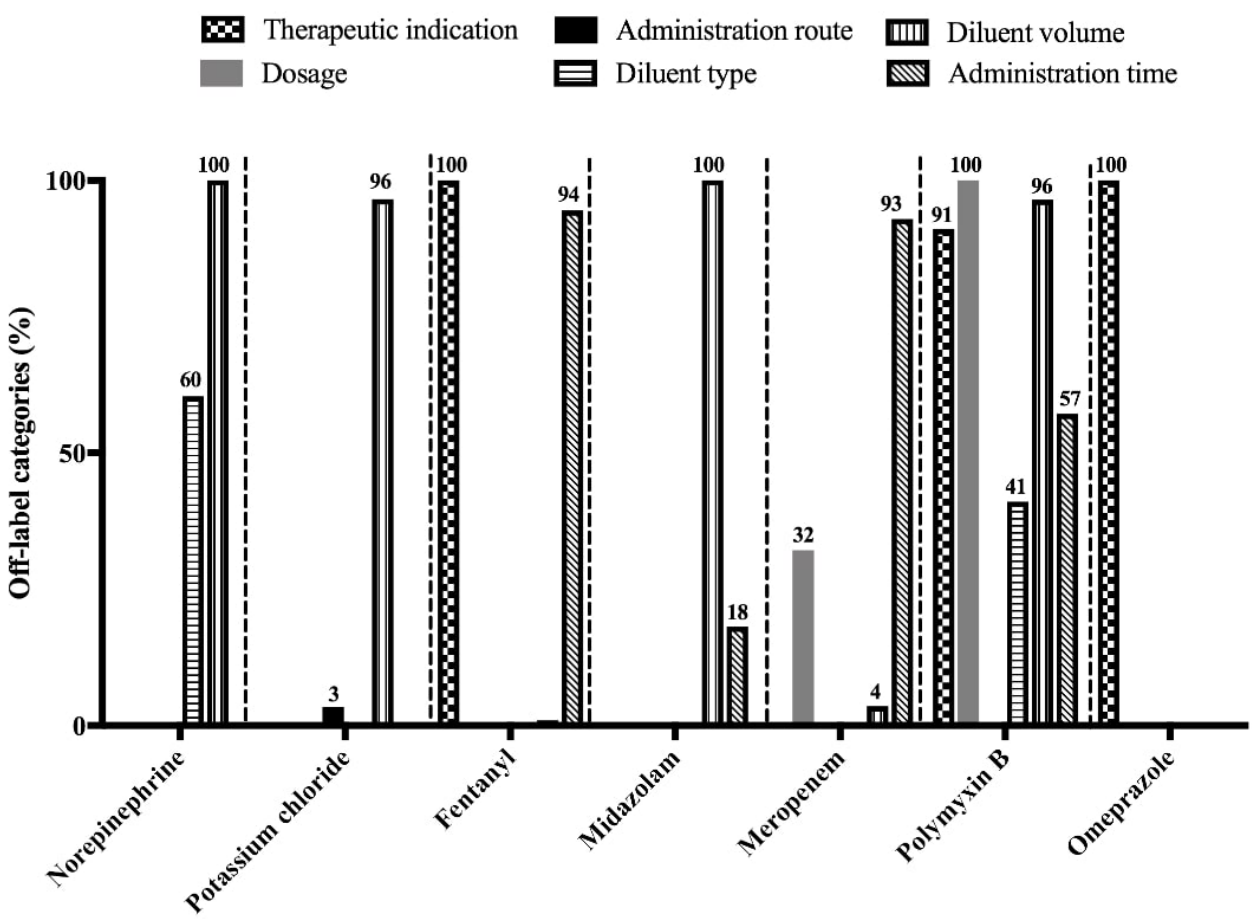
FIGURE 4 - Most prescribed drugs for off-label use and their respective category